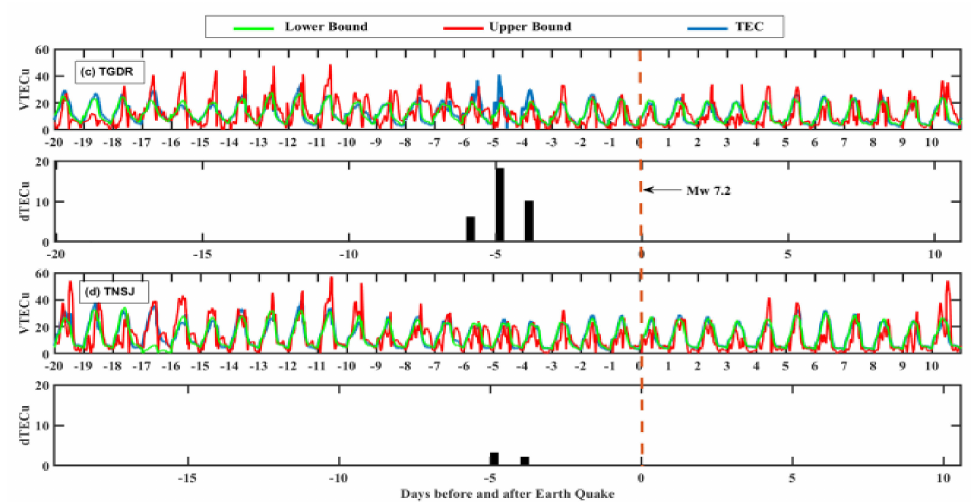
Figure 5. Deviation in VTEC beyond upper bound on the day ( − 6, − 5, − 4) for ( c ) TGDR and ( d ) TNSJ stations before the main shock of M w 7.2 EQ. The red dashed line represents the EQ